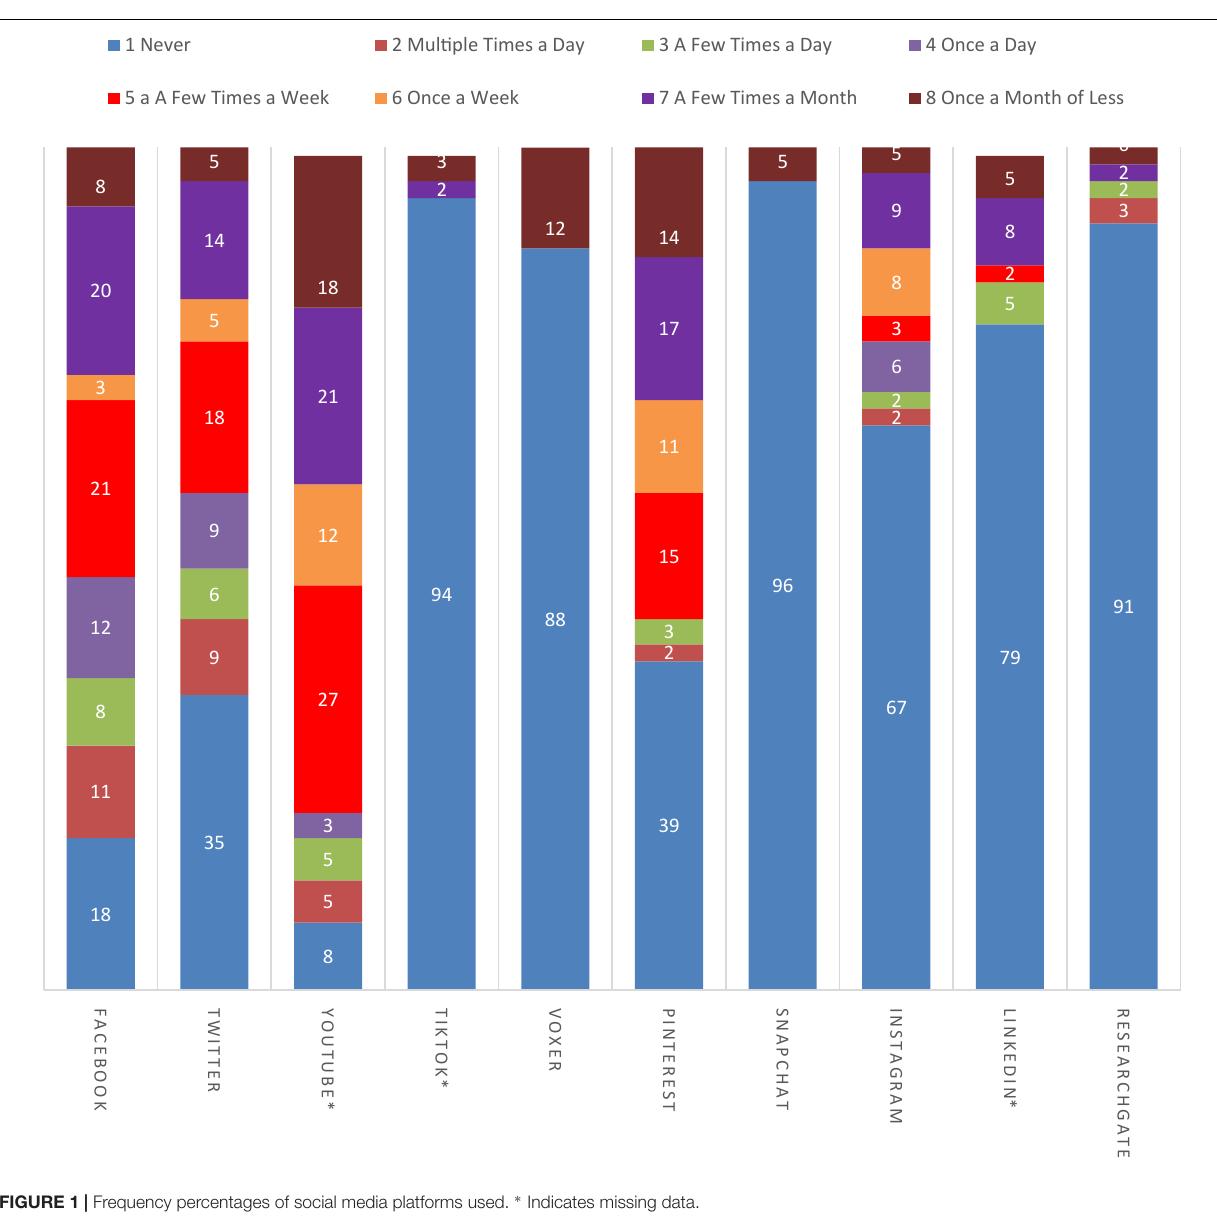
and collaboration impact ( r = 0.41, p <